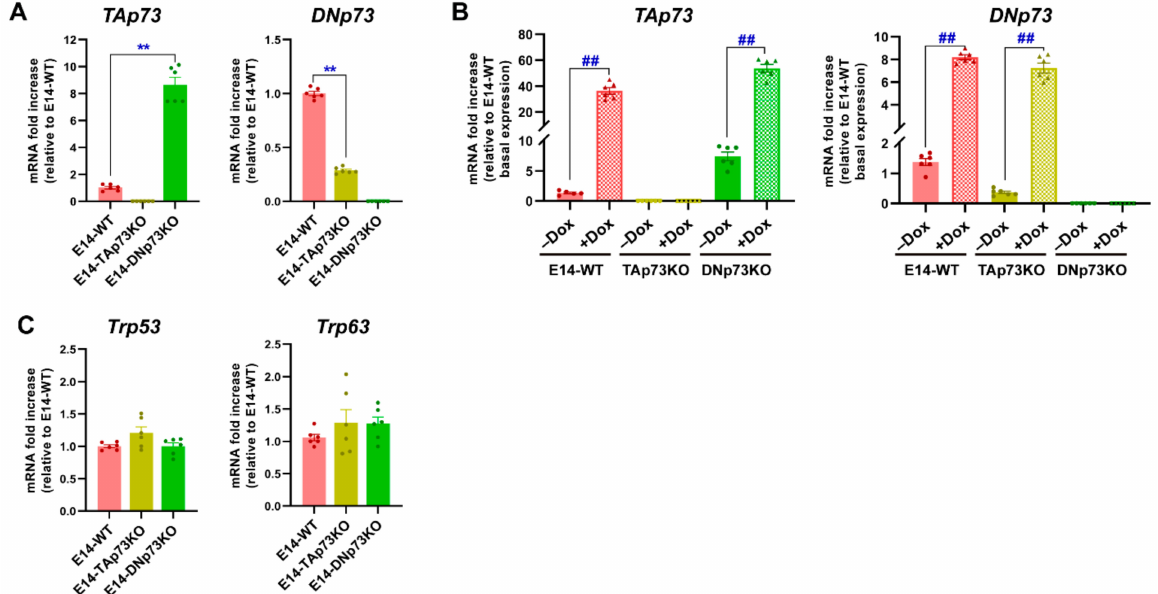
Figure 2. Specific elimination of the TA- or DN-p73 isoform in mESC results in deregulation of the other isoform but does not increase the expression of other family members as part of a compensatory mechanism. ( A , B ) qRT-PCR analysis of TA- and DN-p73 expression levels under basal conditions ( A ) or upon treatment with doxorubicin (Dox) ( B ). ( C ) Expression of Trp53 and Trp63 , analyzed by qRT-PCR. The data represents the mean ± SEM of three independent experiments. **, ## p -value <